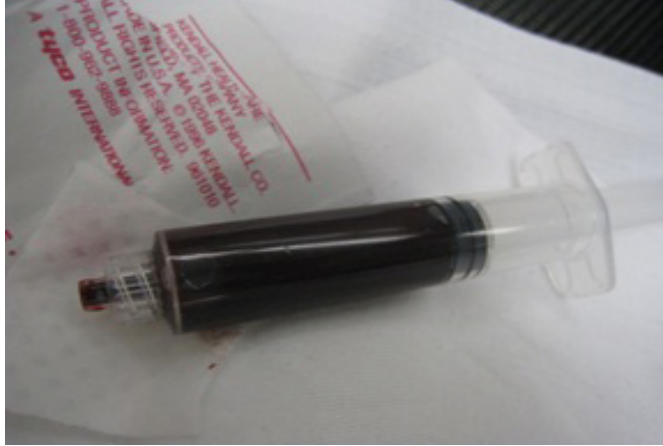
Figure 3. Blood grossly appears chocolate brown